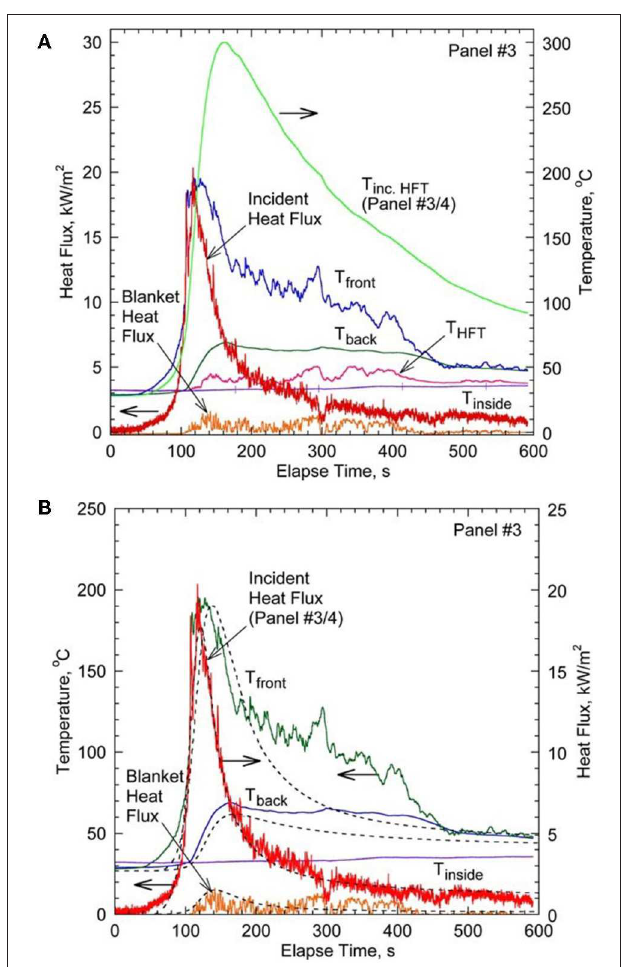
FIGURE 8 | Measurements and calculations in Burn #2. (A) Measured incident and through-the-fabric heat fluxes, and temperatures at the fabric front and back surfaces and the back (inside) of the wood sheath of Panel #3, and (B) calculated (dashed curves) fabric front and back surfaces and through-the-fabric heat flux based on the prescribed incident heat flux from the